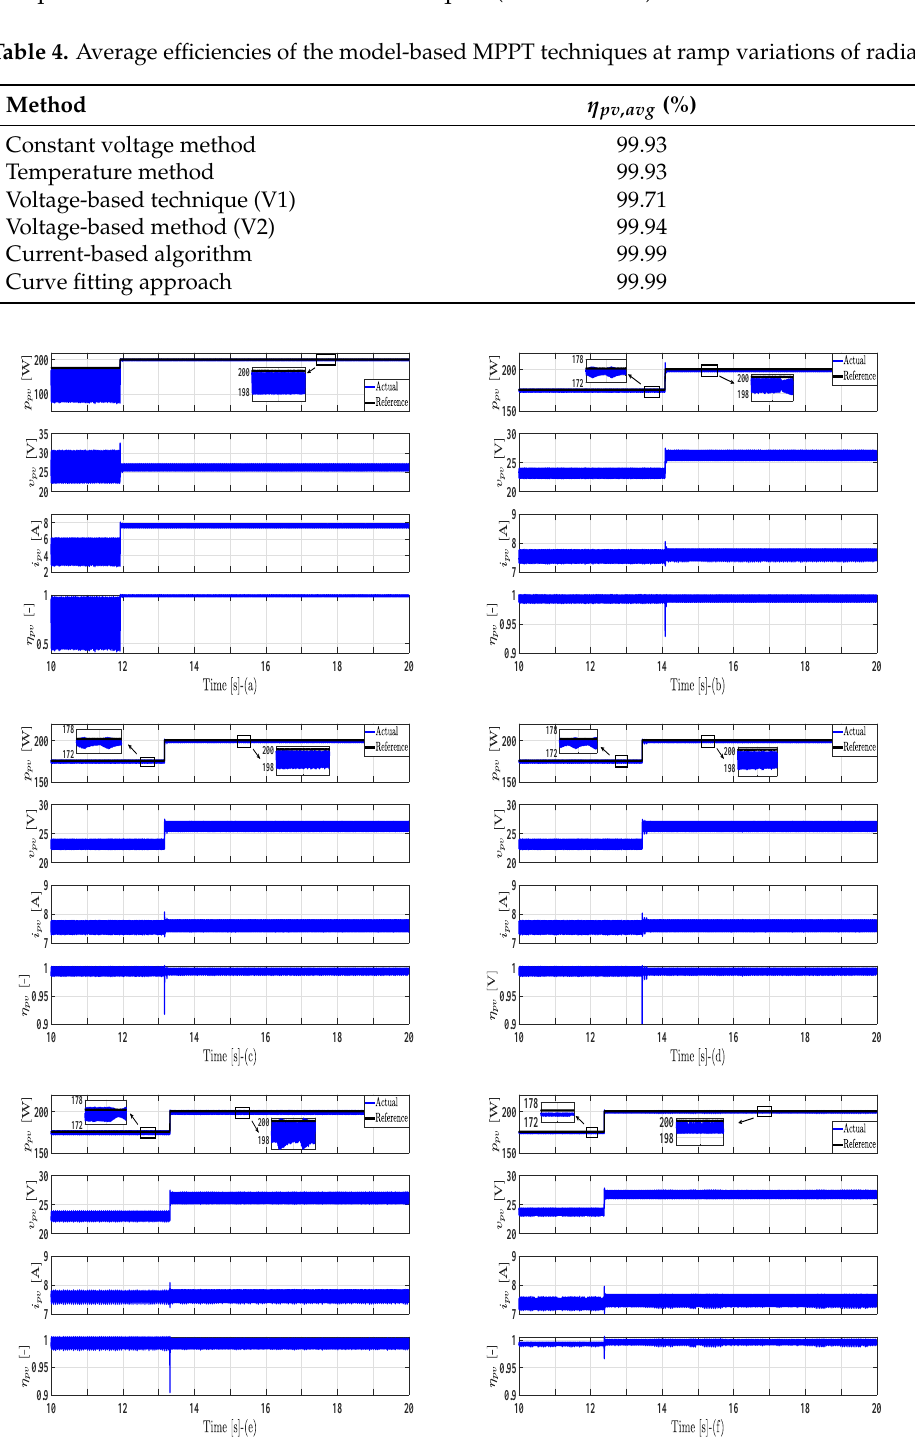
Figure 5. The performance of model-based MPPT methods at step changes of temperature. ( a ) Constant voltage method, ( b ) temperature method, ( c ) voltage-based method (V1), ( d ) voltage- based technique (V2), ( e ) current-based algorithm, ( f ) curve fitting